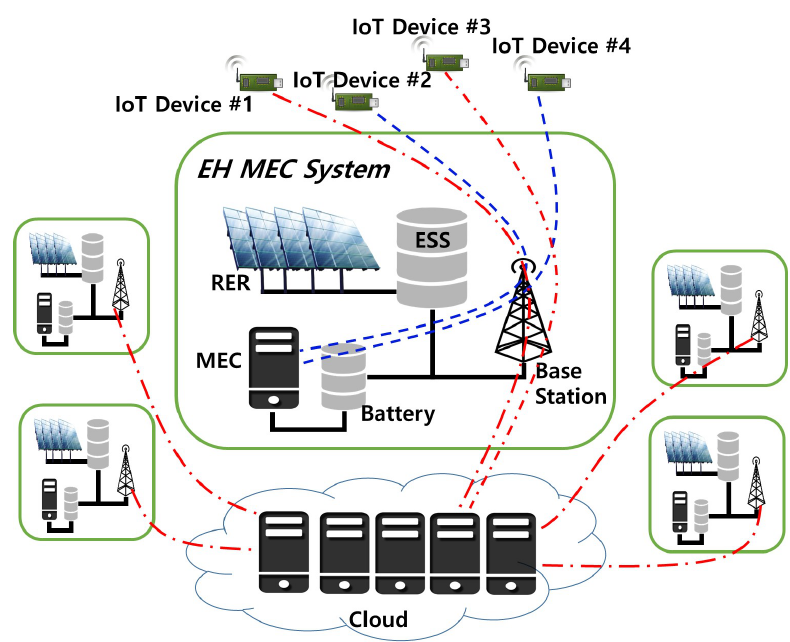
Figure 1. Architectural view of the proposed EH MEC system, consisting of RERs, energy storage system (ESS), a base station, MEC, etc. The IoT devices send their computational workloads to the base station. If the computation can be performed by the EH MEC system, it is offloaded to the MEC. Otherwise, it is offloaded to the cloud